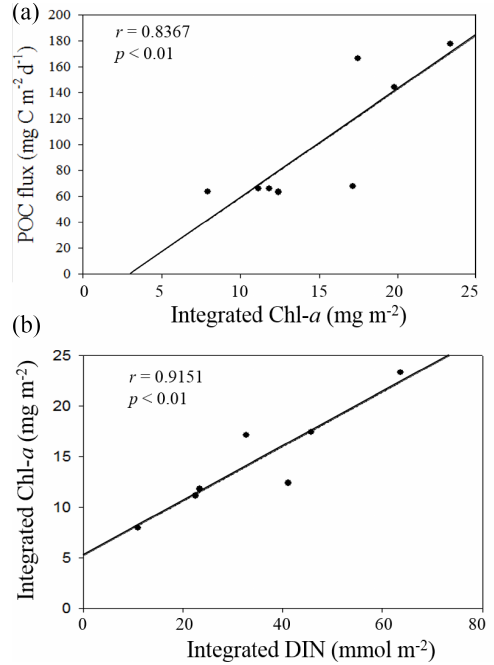
Figure 10. Plots of positive correlations between integrated Chl a and vertical POC fluxes (a) and between DIN inventories and Chl a inventories in the euphotic zone (b)